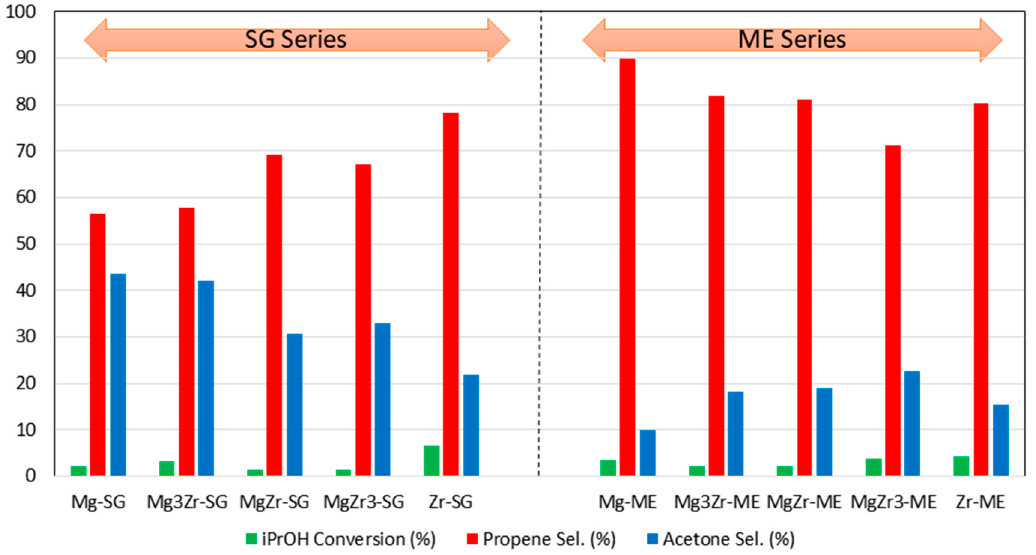
Figure 6. Catalytic activity in the gas-phase propanl-2-ol test reaction for the catalysts prepared in this work. Propan-2-ol conversion and selectivity to propene and acetone obtained at 250 °C.